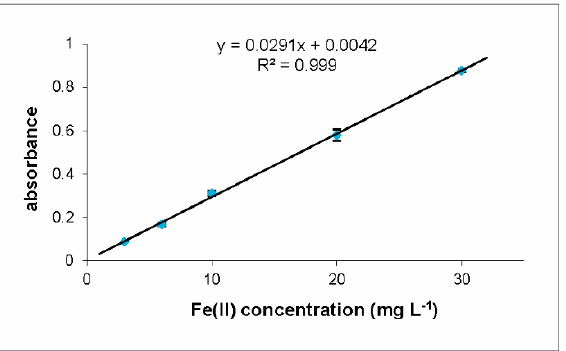
Figure 3. The calibration graph for Fe(II) determination. Each point represents the mean of four consecutive measurements. Bars indicate the standard deviations. consecutive measurements. Bars indicate the standard